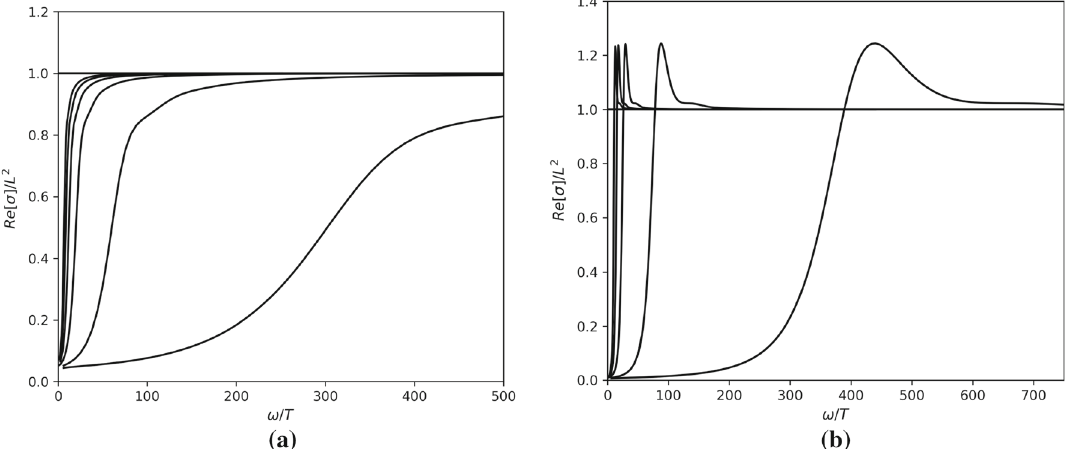
Fig. 7 The evolution of Re σ (ω) versus ω/ T at ε = 4 π, Q = 1 , L = 9 for O 1 (a) and O 2 (b). Each graph, from left to right, is plotted for the cases T / T c = 0.7, 0.5, 0.3, 0.1 and 0.02